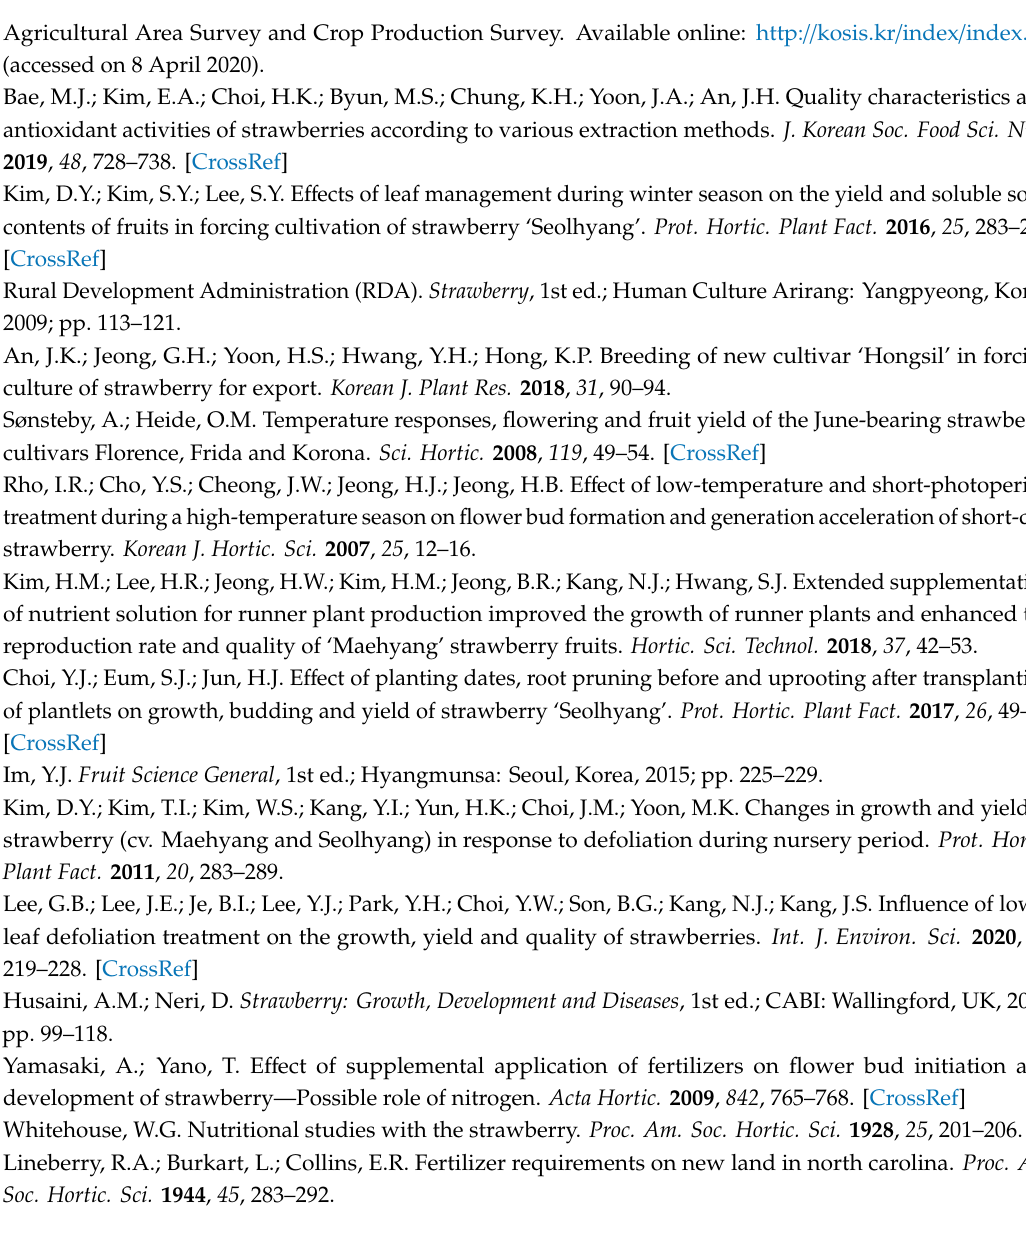
Figure S1: Microscopic view of flower bud development stages on the apical meristem of “Maehyang” strawberry runner plants a ff ected by the nutrient solution resupply period at transplanting day. The flower bud development stage was classified into 7 stages (0 to 6). The stages are as follows: 0, the vegetative apex stage; 1, the early apex enlargement stage; 2, the middle apex enlargement stage; 3, the later apex enlargement stage; 4, the apex division stage; 5, the sepal development stage; 6, the stamen development